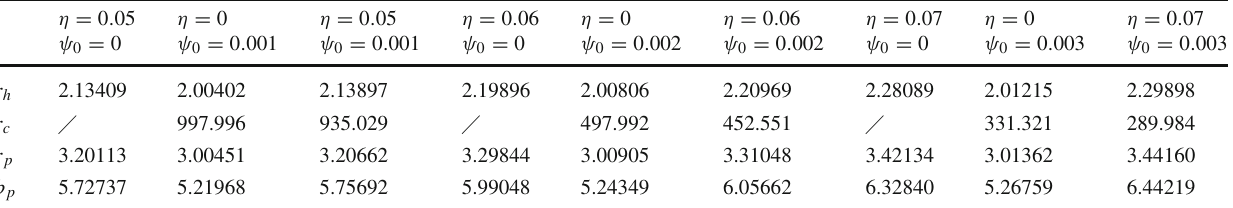
Table 1 The numerical results of the event horizon r h , the cosmological horizon r c , the radius r p and impact parameter b p of photon sphere, where the value of M is set to 1